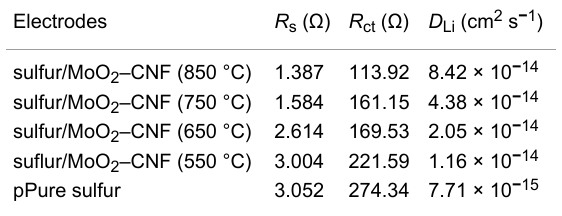
Table 4: Impedance parameters of the